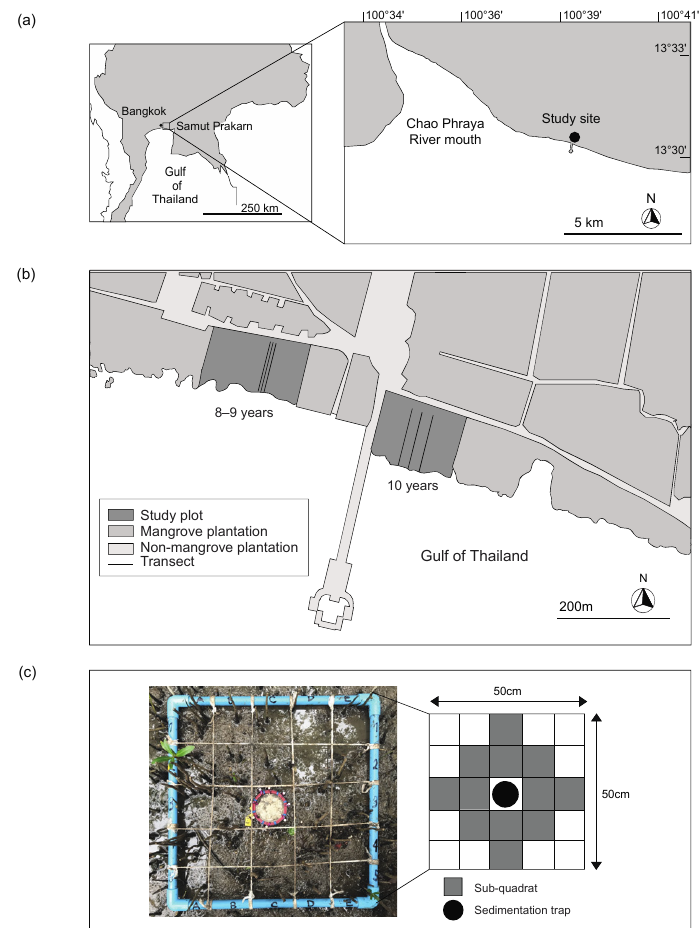
Figure 1. Location of the mangrove plantation in Samut Prakarn province in central Thailand. ( a ) study site on the eastern shore of the Chao Phraya River mouth; ( b ) study plots in the mangrove plantations; and ( c ) a quadrat for a study of pneumatophore characteristics and sedimentation rates. The climatic data over 10 years from January 2009 to December 2019 were received